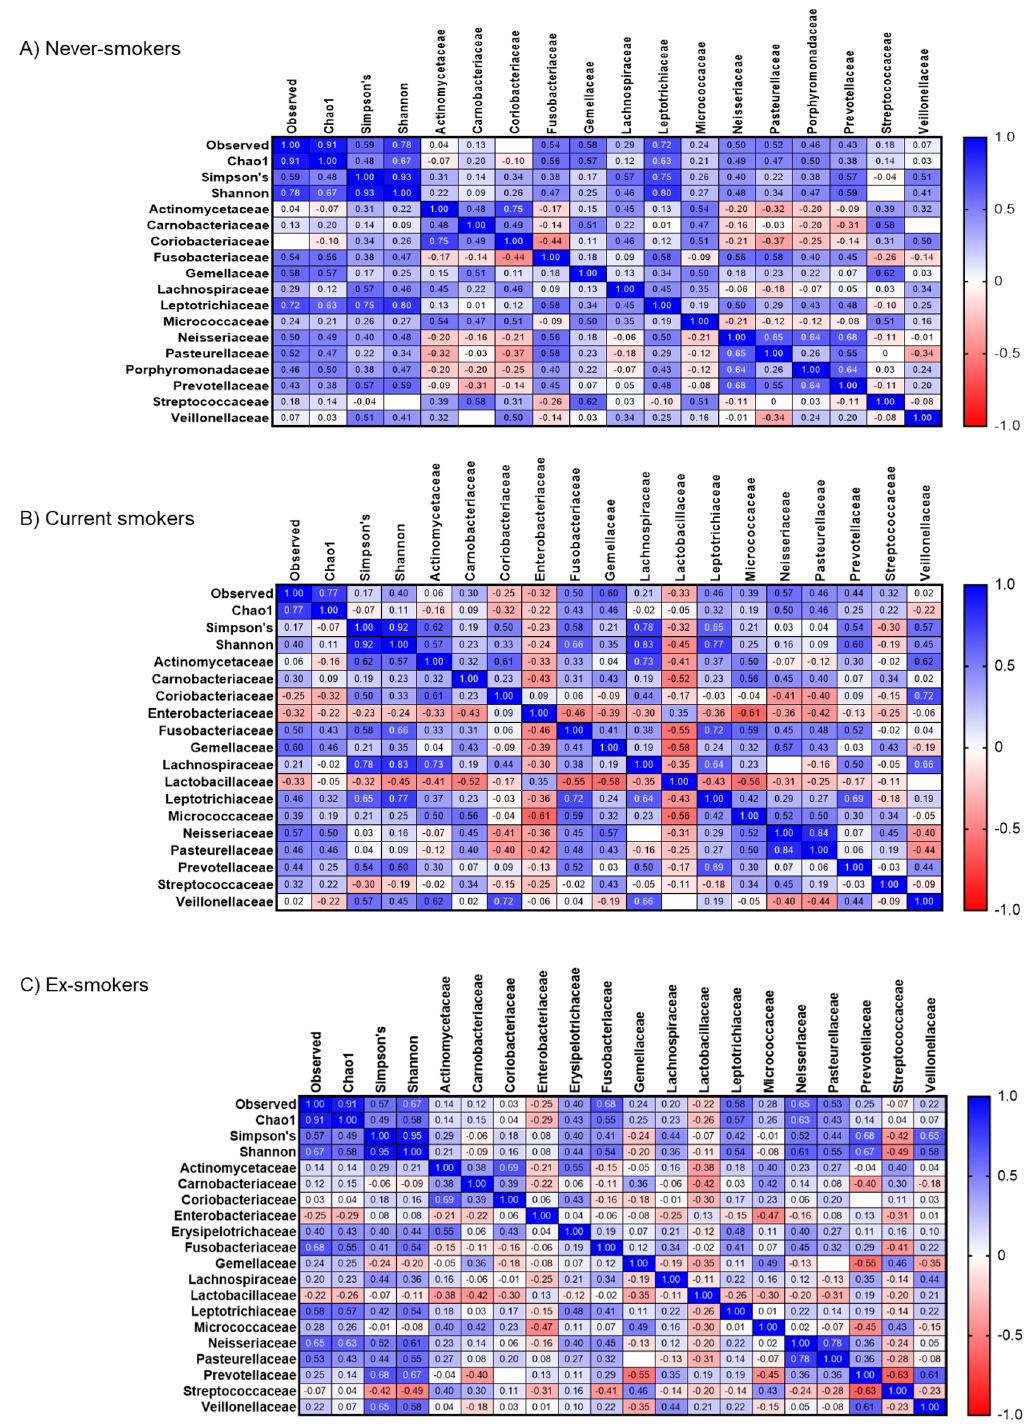
Figure 3. Spearman associations between duodenal microbial families in never-smokers ( A ), current smokers ( B ), and ex-smokers ( C